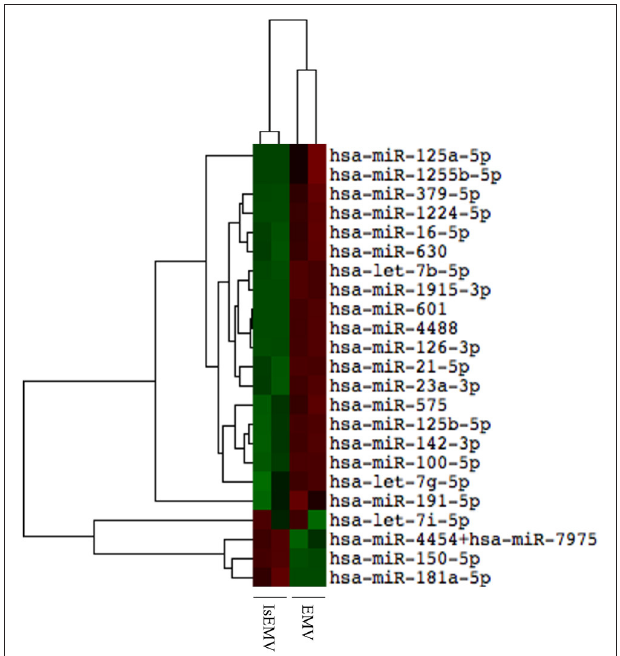
FIGURE 4 | Hierarchical cluster analysis of miRNAs in microvesicles (MV). Heat map of differentially expressed miRNAs in MV derived from IS-treated HUVECs (IsEMV) and from untreated HUVECs (EMV). Each sample ( n = 2) constitutes pooled cultured HUVECs. Red indicates upregulated miRNA expression and green indicates downregulated miRNA